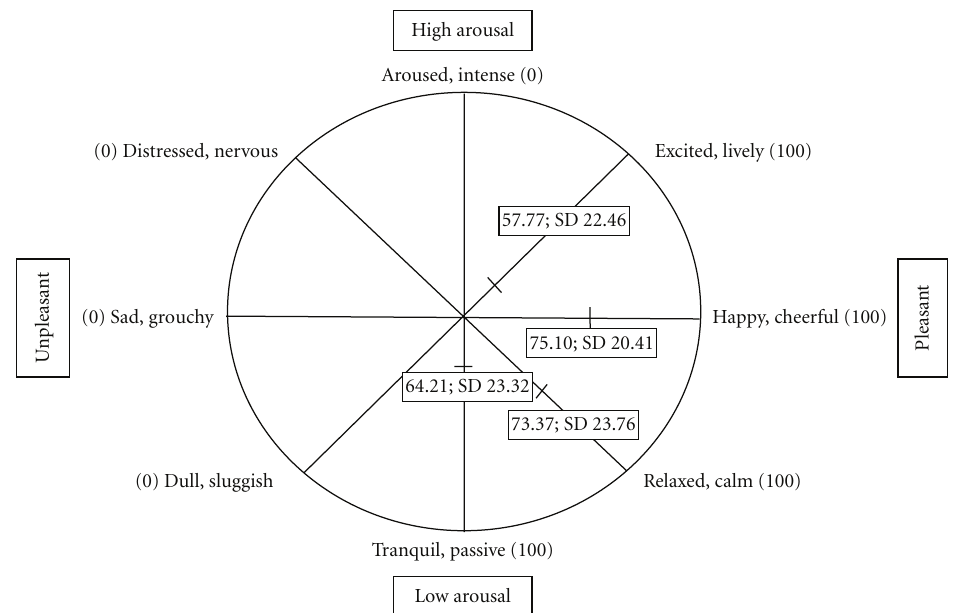
Figure 1: Score of visual analog scale on circumplex model of emotion. The 4 diameters shown represent the 8 pairs of adjectives used for the VAS items that generated the valence and arousal scores. The short perpendicular mark on each diameter represents the mean value for the corresponding VAS items in this sample.